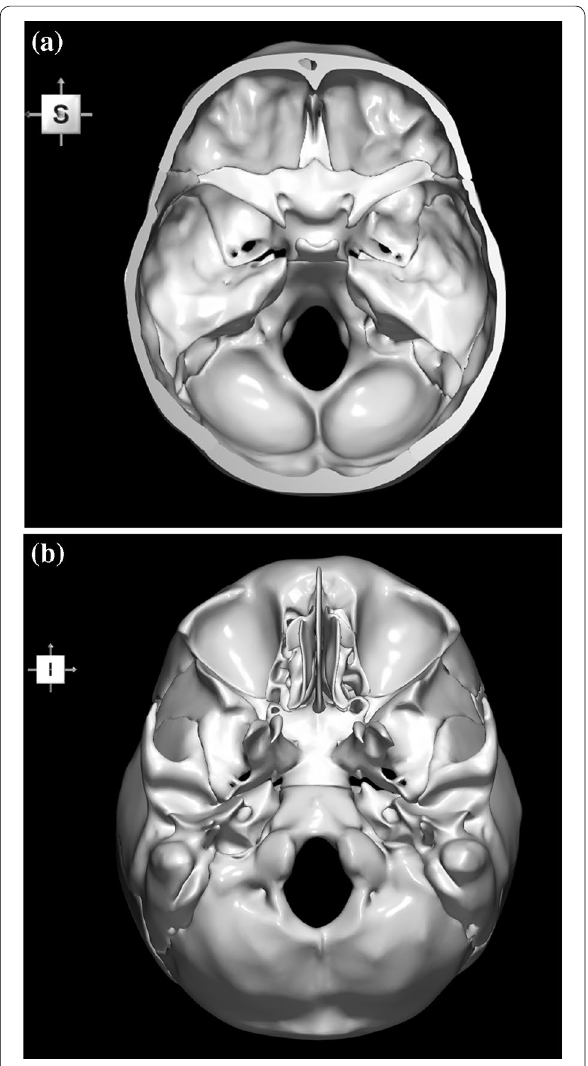
Fig. 1 Skull base: a internal surface (superior view); b external (basal) surface (inferior view). The orientation box located in the top-left corner indicates the viewing direction ( S superior, I inferior, A anterior, P posterior, L left, and R right)